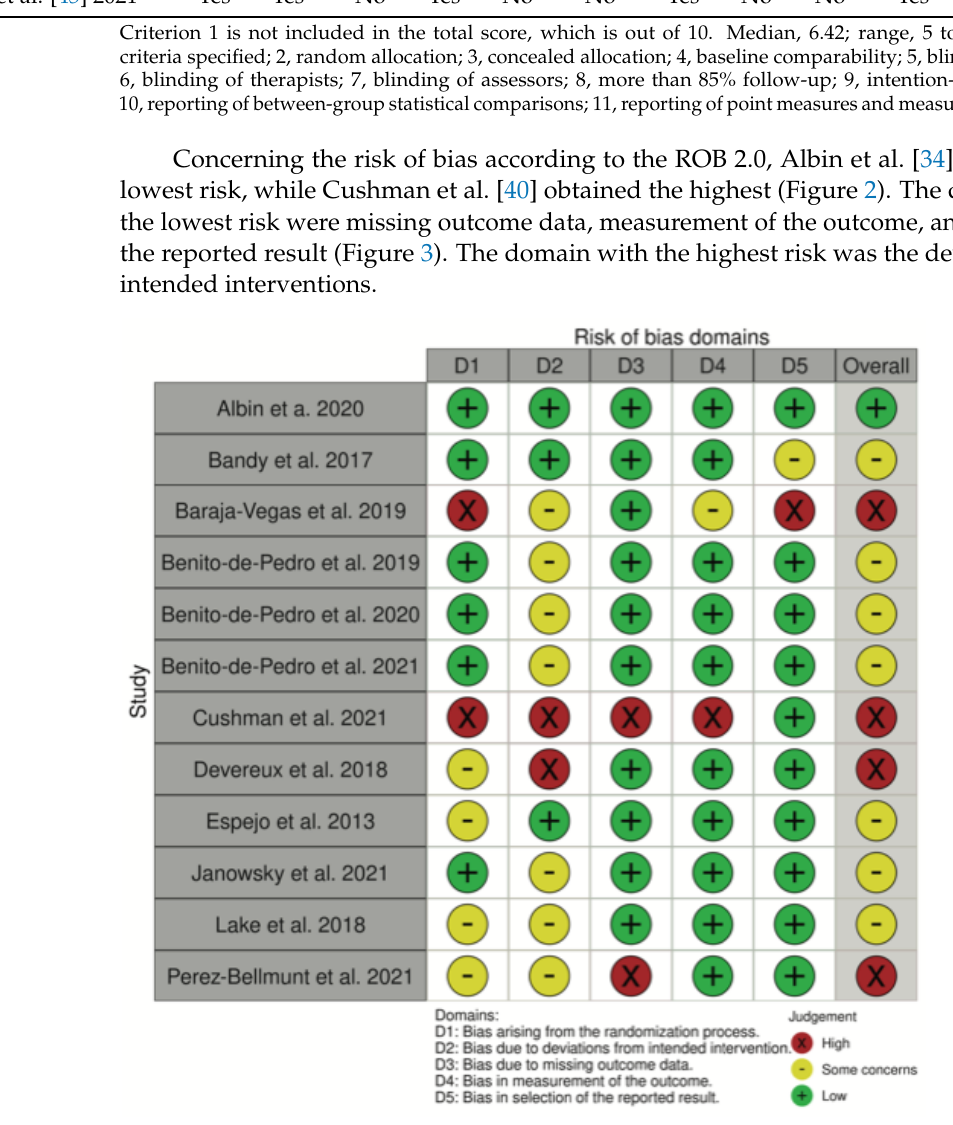
Figure 2. Risk of bias of the studies included in the systematic review.